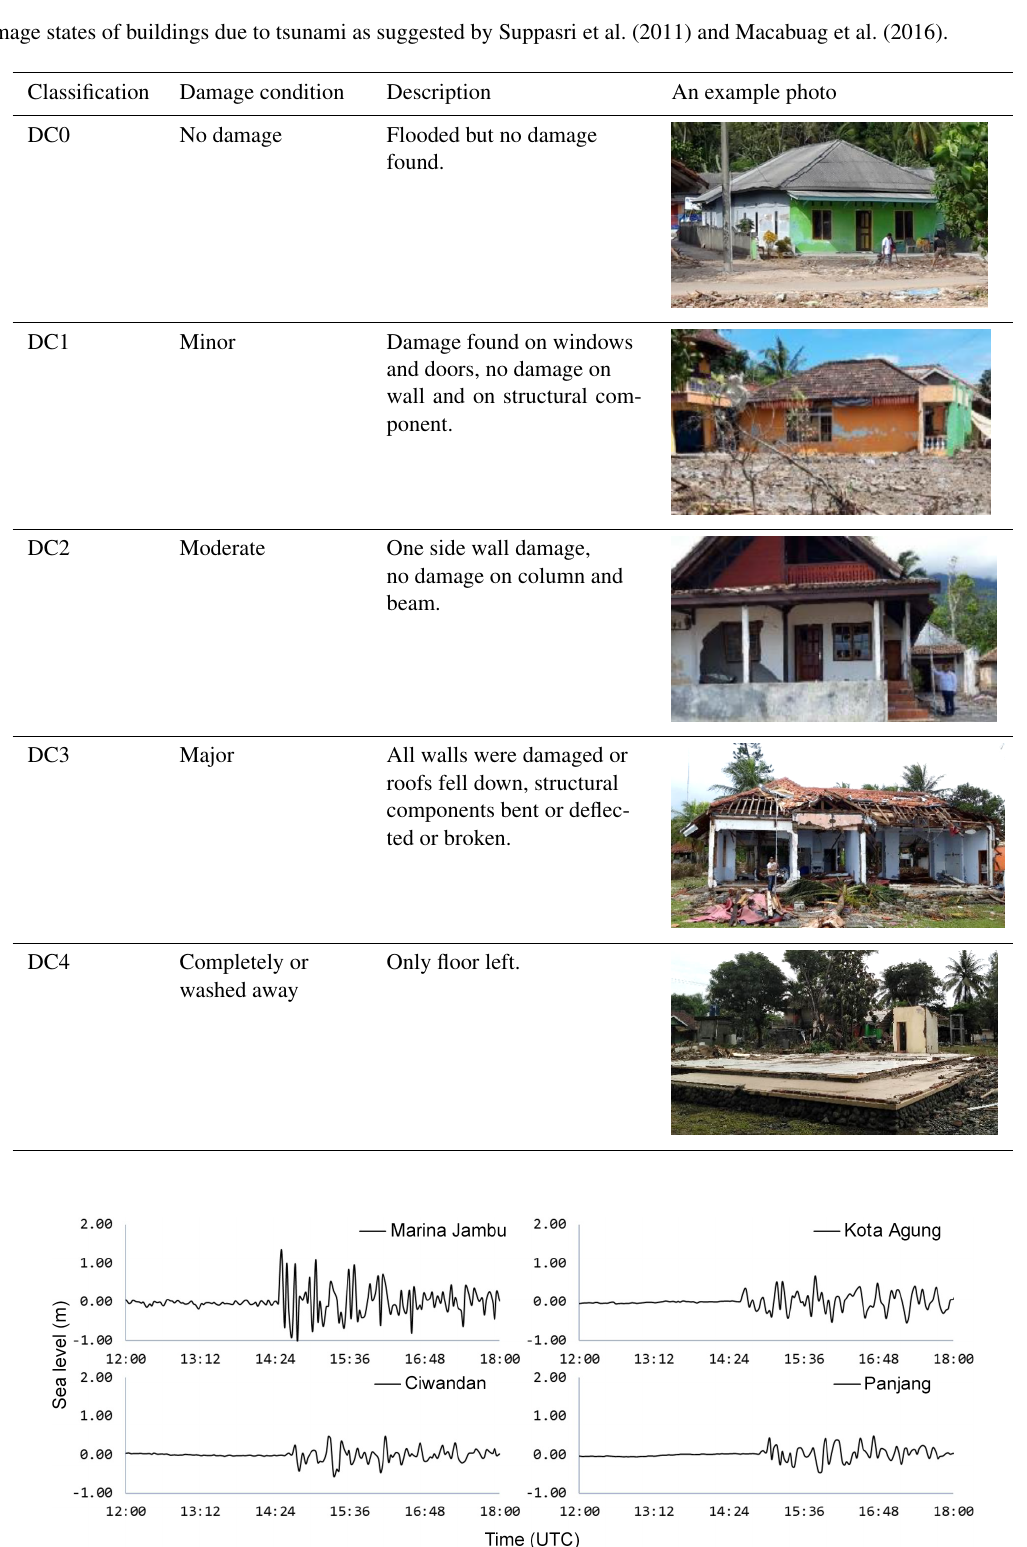
Figure 2. Filtered water elevation fluctuations measured at four tide-gauge stations around Sunda Strait, indicating the tsunami wave at